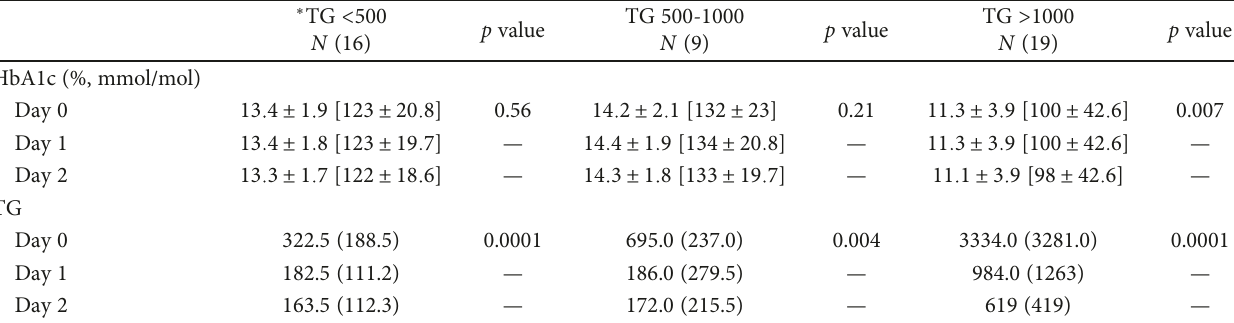
Table 4: Comparison between triglyceride